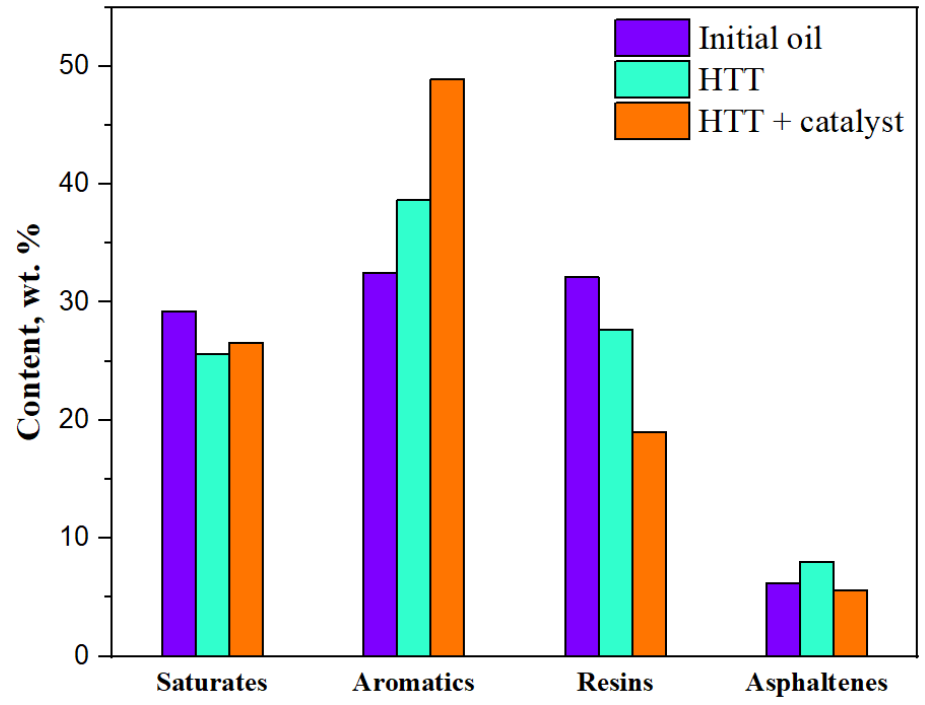
Figure 6. The group composition of oil